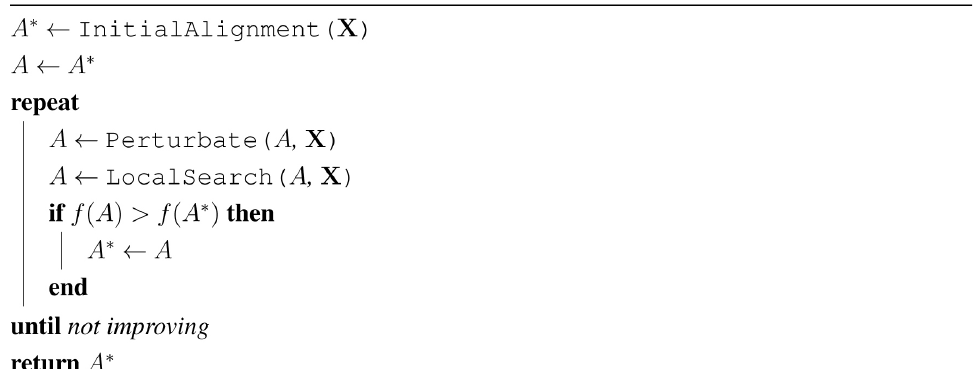
Algorithm 1: Overview of CytoMCS